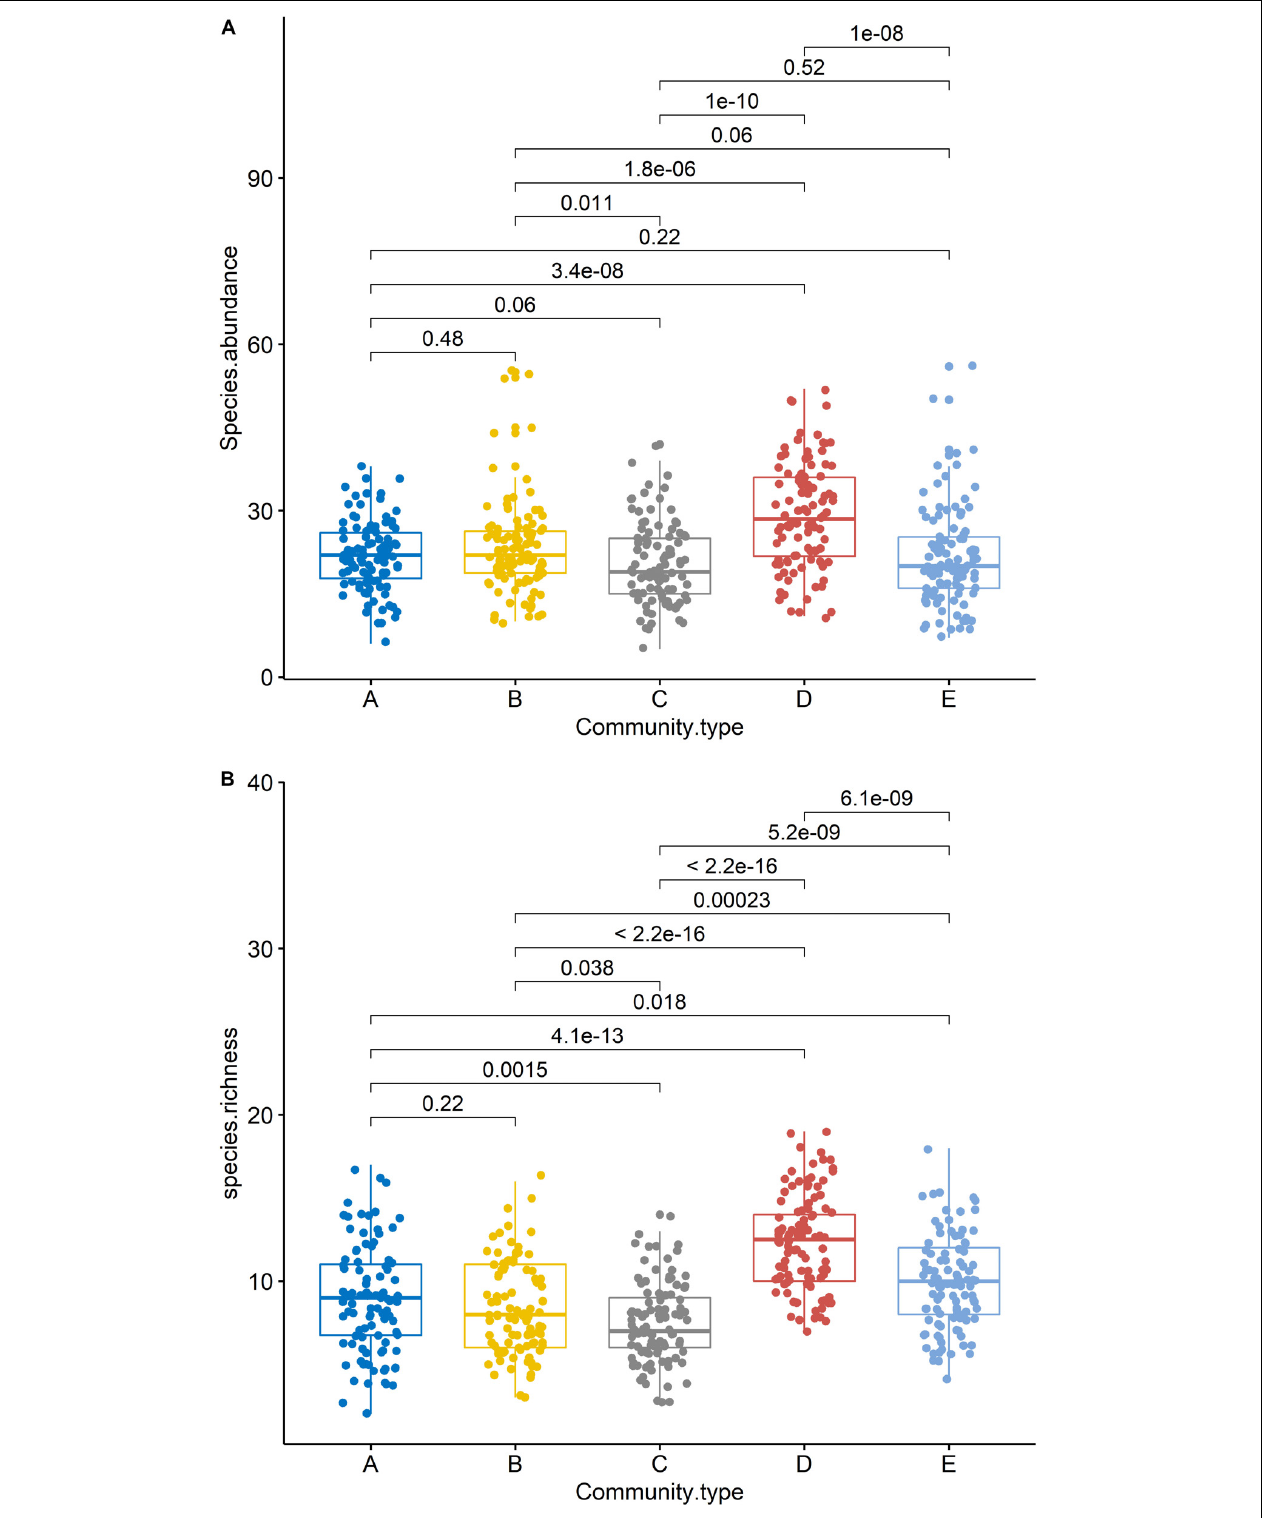
FIGURE 3 | Species richness (A) and abundance (B) of woody plants in five communities. Black lines indicate significant differences, as obtained using the Kruskal–Wallis method ( P ≤ 0.05 level of significance). A, B, C, D, and E were the Quercus variabilis community, Quercus glandulifera var. brevipetiolata community, Mixed broadleaf-conifer community, Quercus aliena var. acutiserrata community, and Miscellaneous wood community, respectively.